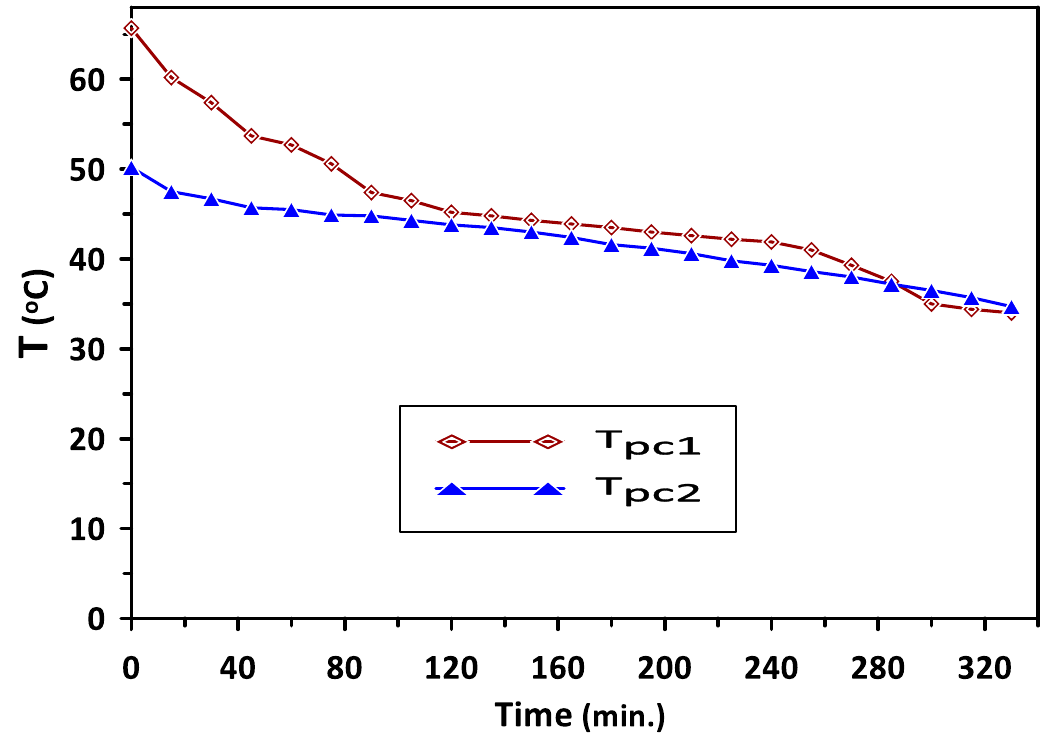
Figure 6. Variations in PCM1 and PCM2 temperatures with time during the discharge cycle at ambient air temperature of 30 °C.